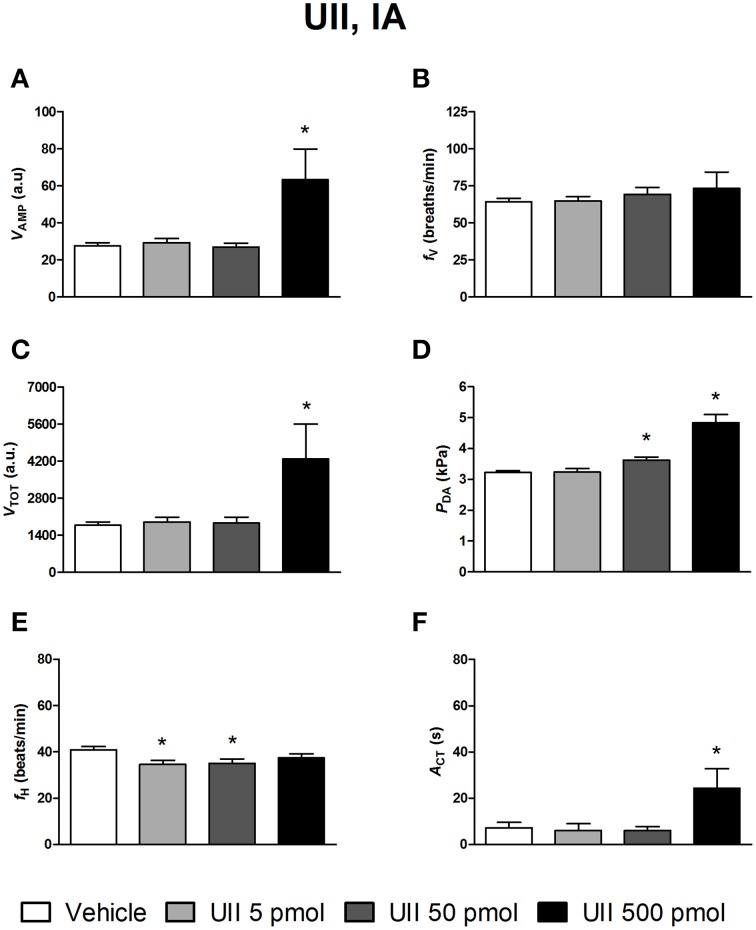
Histograms showing the maximal effects of IA injection of 50 μl vehicle (n = 29), 5 pmol UII (n = 10), 50 pmol UII (n = 16) and 500 pmol UII (n = 7) on ventilatory amplitude (VAMP, A), ventilatory frequency (fV, B), total ventilation (VTOT, C), dorsal aortic blood pressure (PDA, D), heart rate (fH, E), and motor activity (ACT, F). *P < 0.05 vs. vehicle injection.